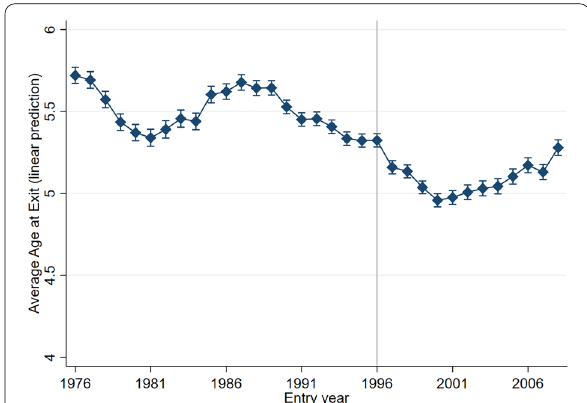
Table 8 Establishment exits as a function of the wage